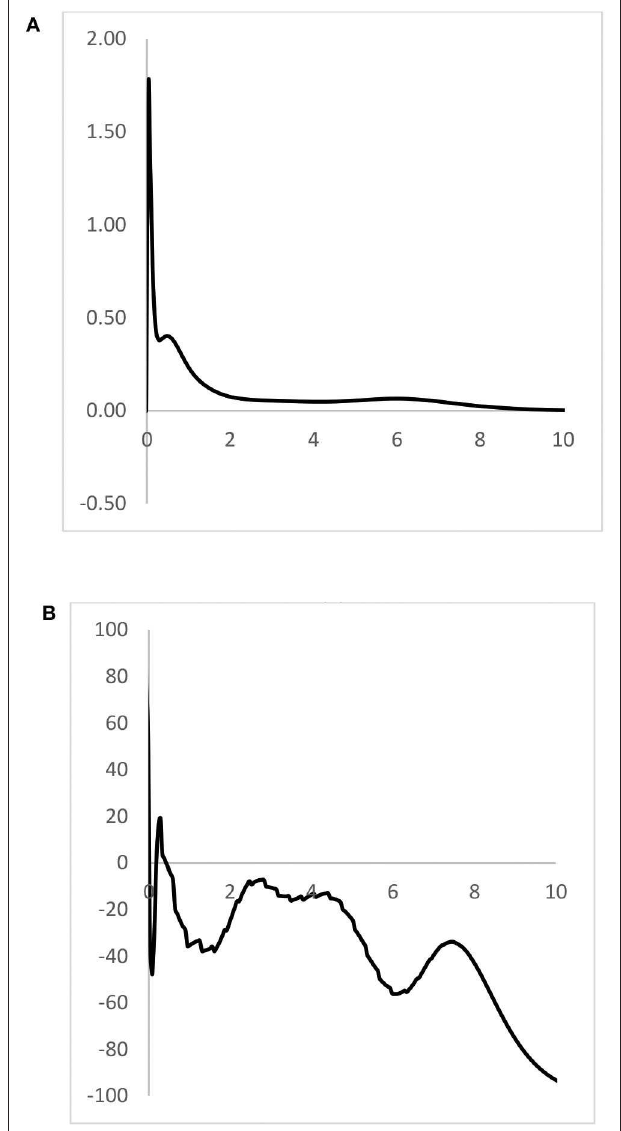
FIGURE 6 | Comparison of the ergodic distributions and MPPs of the oil market for all countries across time. Note: For (A) , horizontal axis represents relative per capita consumption, vertical axis represents proportion. For (B) , horizontal axis represents relative per capita consumption, vertical axis represents MPP. Source: Authors’ calculation.